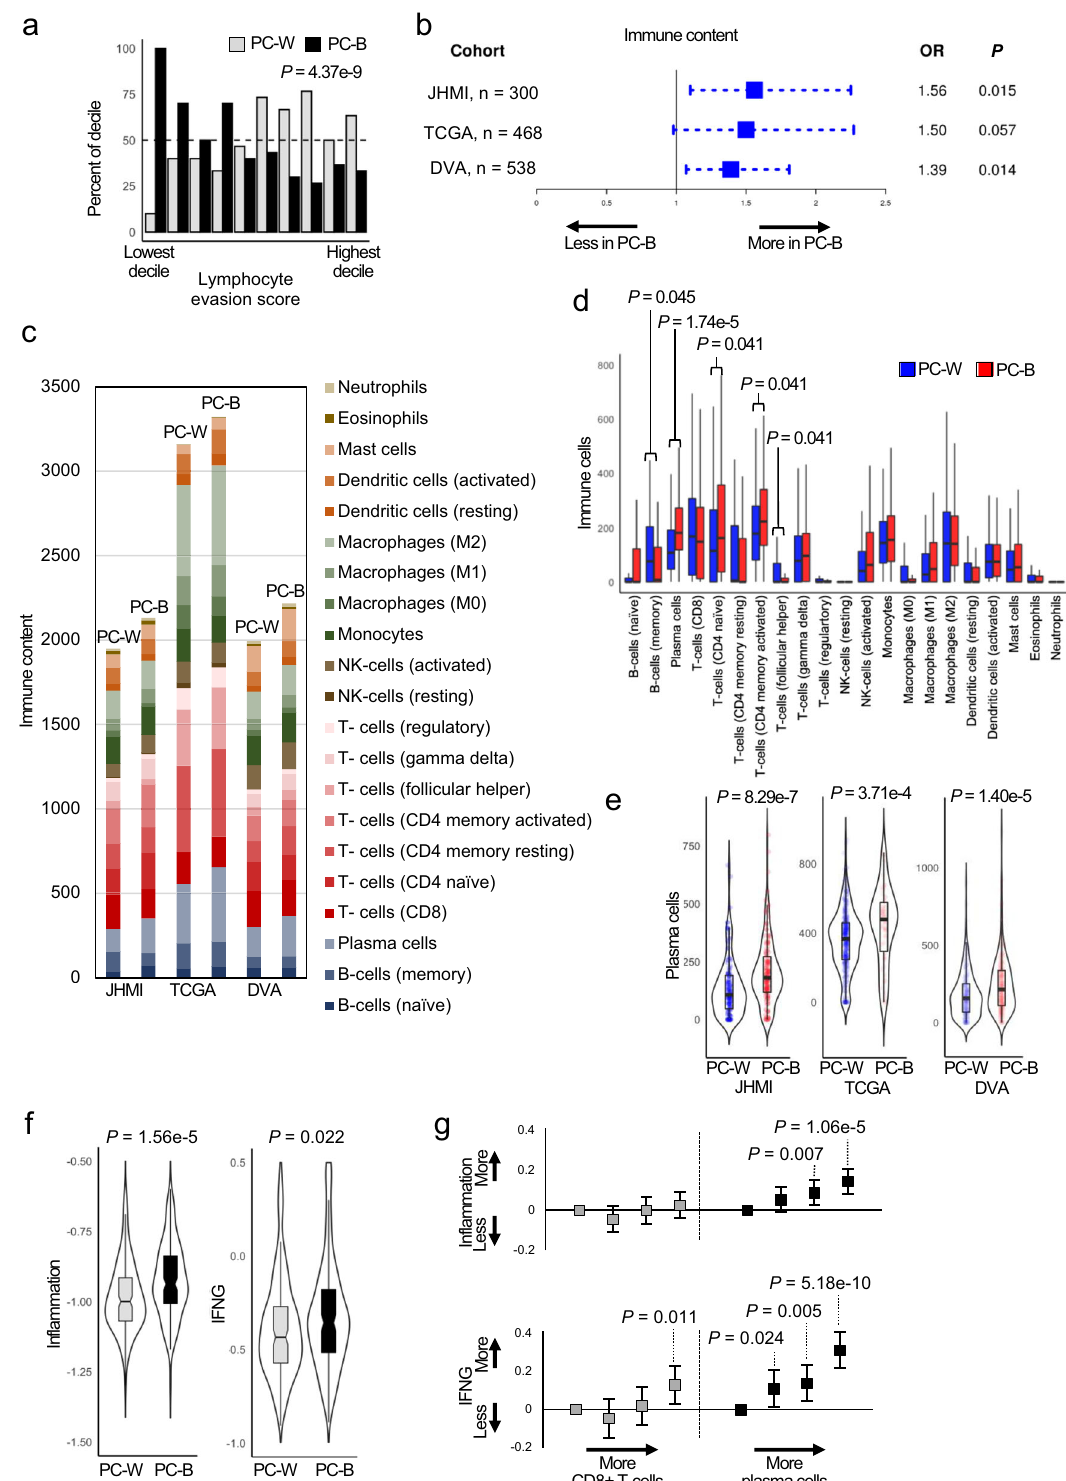
Plasma cell content prognosticates outcomes following surgery